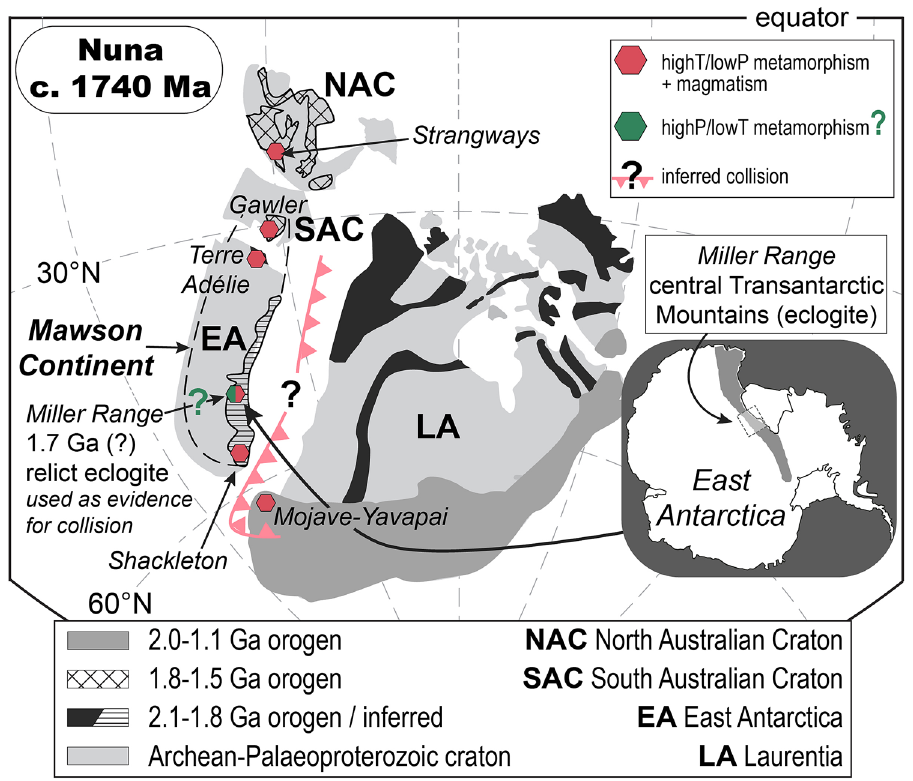
Figure 1. Palaeogeographic reconstruction of Nuna modified after Zhang et al. 3 , Betts et al. 5 , and Goodge et al. 21 . Modified using Adobe Illustrator (v. 24.3, https:// www. adobe. com/ au/ produ cts/ illus trator. html) 22 . The approximate boundary of the Mawson Continent is shown with a dashed line 23 . The modern position of the Miller Range is shown by the inset map. The palaeogeographic locations of the Mojave and Yavapai provinces, Shackleton Range, Miller Range, Terre Aélie, Gawler Craton and Strangways Orogen show the occurrences of Palaeoproterozoic metamorphism and magmatism in these regions, collectively used to link sites of orogenesis and to infer a Palaeoproterozoic plate boundary position for the Miller Range adjacent to Laurentia. The timing of active plate-margin orogenesis and amalgamation of Australia/East Antarctica and western Laurentia is debated, with assembly by c. 1740 Ma 3,10–12 or 1600–1500 Ma 4–9 . The previously interpreted occurrence of c. 1720 Ma eclogite-facies metamorphism in the Miller Range has been used as an indicator of plate-margin orogenesis between Australia/East Antarctica, and western Laurentia, consistent with the former model for